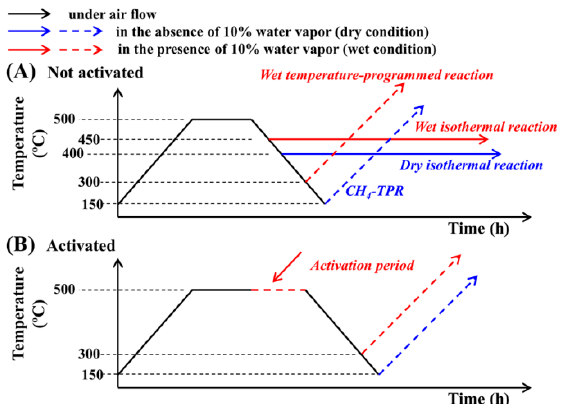
Figure 9. Experimental procedures of CH 4 -TPR and CH 4 combustion reaction for ( A ) the non- activated and ( B ) activated